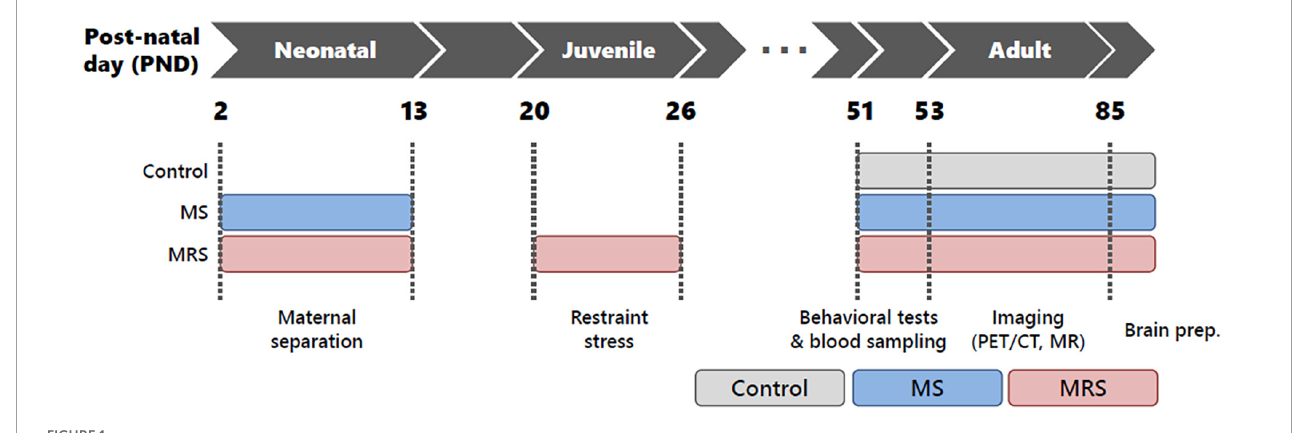
FIGURE1 Schematic of the study